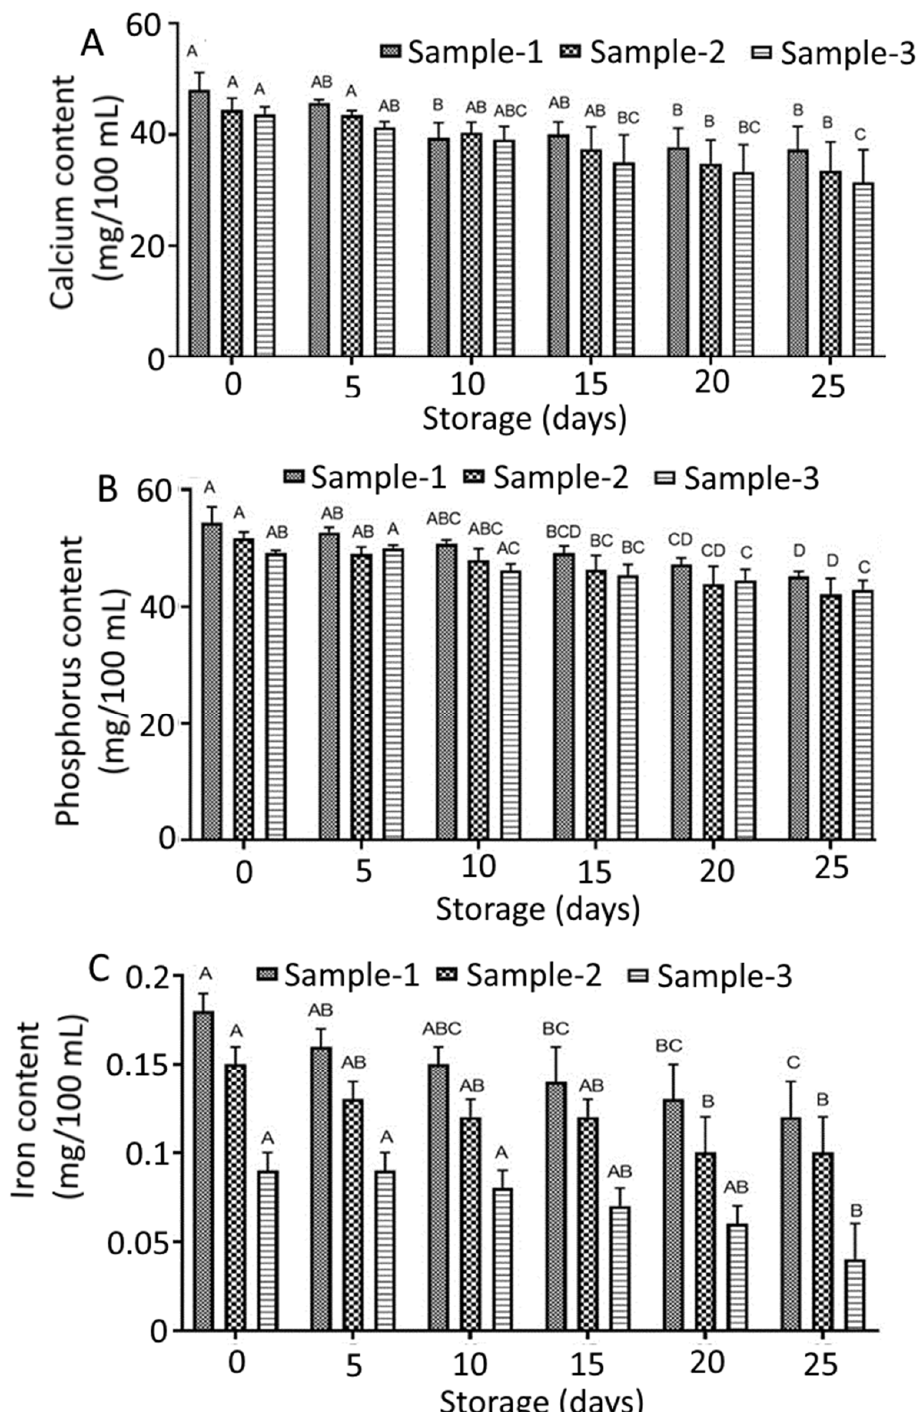
Figure 1. Minerals profile of whey-based mixed beverages: ( A ) calcium content; ( B ) phosphorus content; and ( C ) iron content. All the values are expressed as mean ± standard deviation of three replicates. Different uppercase letters above the same pattern bars indicate significant differences according to Tukey’s multiple comparison test ( p < 0.05).